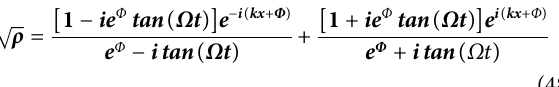
Frontiers in Earth Science |